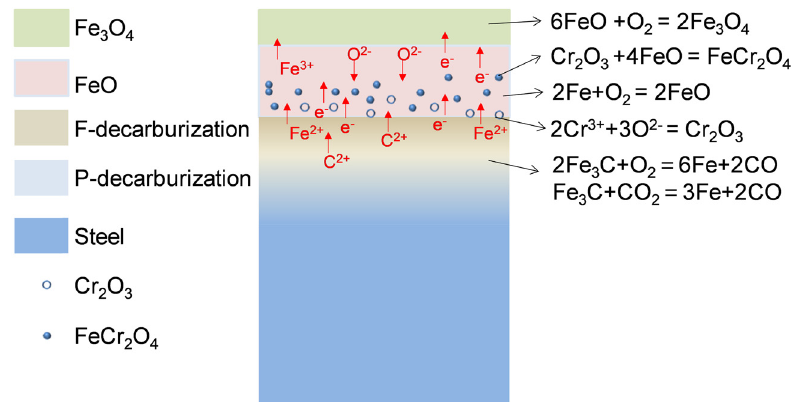
Figure 9: Mechanism of surface decarburization and oxide - scale formation.